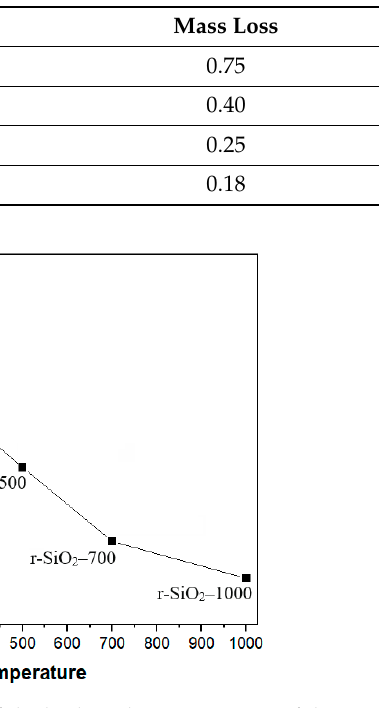
Figure 10. The evolution of the hydroxyl group content of the SiO 2 aggregate without heat treatment and heated at 500 ◦ C, 700 ◦ C, and 1000 ◦